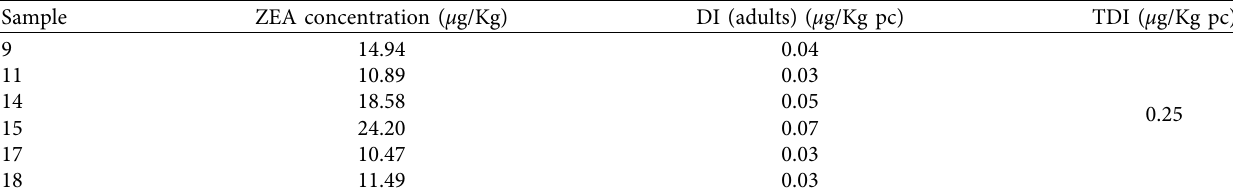
Table 3: Estimation of daily zearalenone intake from eating contaminated